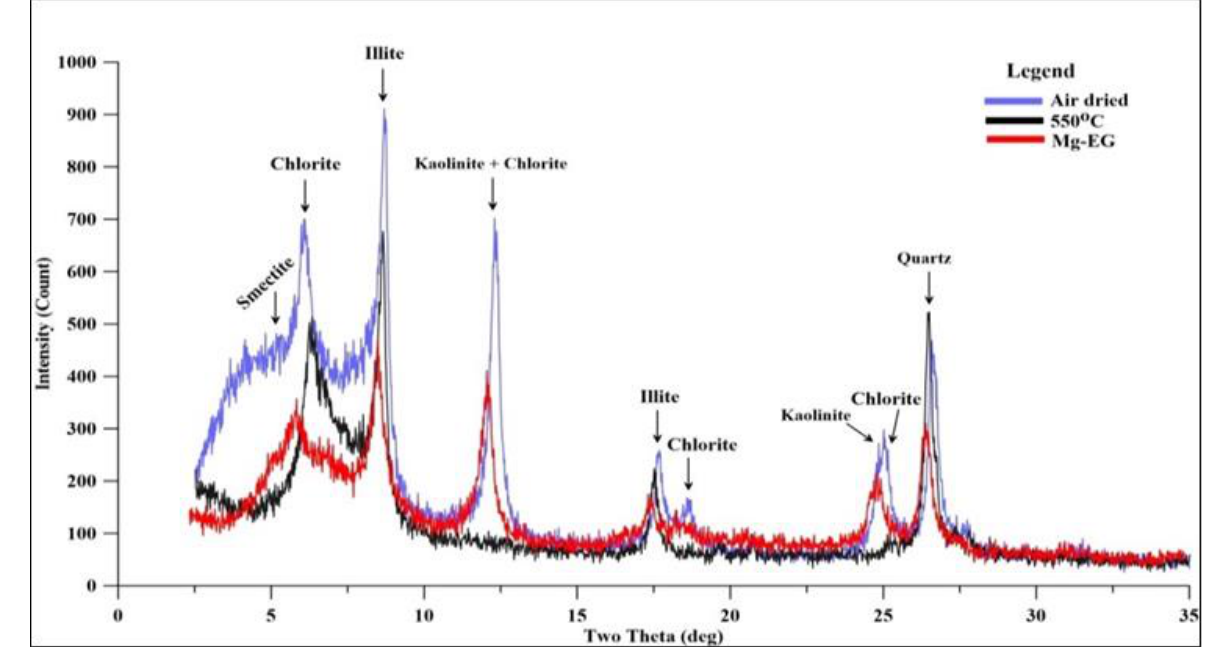
Figure 9. X-ray diffraction pattern of clay fraction of shale from Srikail-3 well sample no. (1c) at 3083